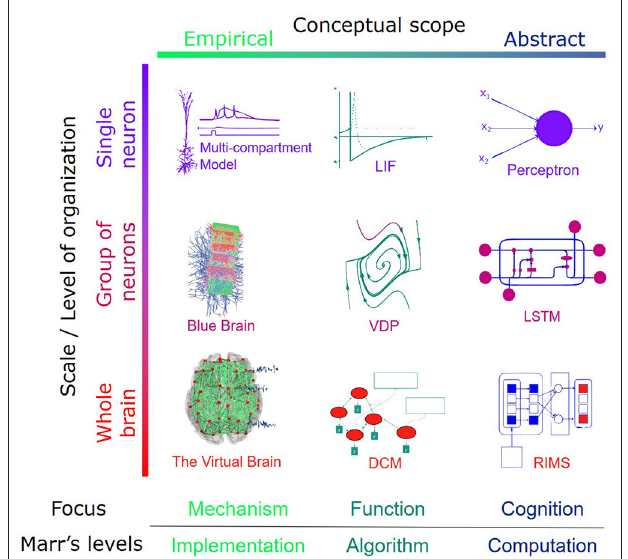
FIGURE 3 | Instances of modeling across different levels of the organization and problem dimension. The conceptual scope is an indicator of biophysical details incorporated in the model. It determines how the focus of the model is directed toward mechanistic reality or the behavioral output. It is also an indicator of where a given model sits on the Marr’s